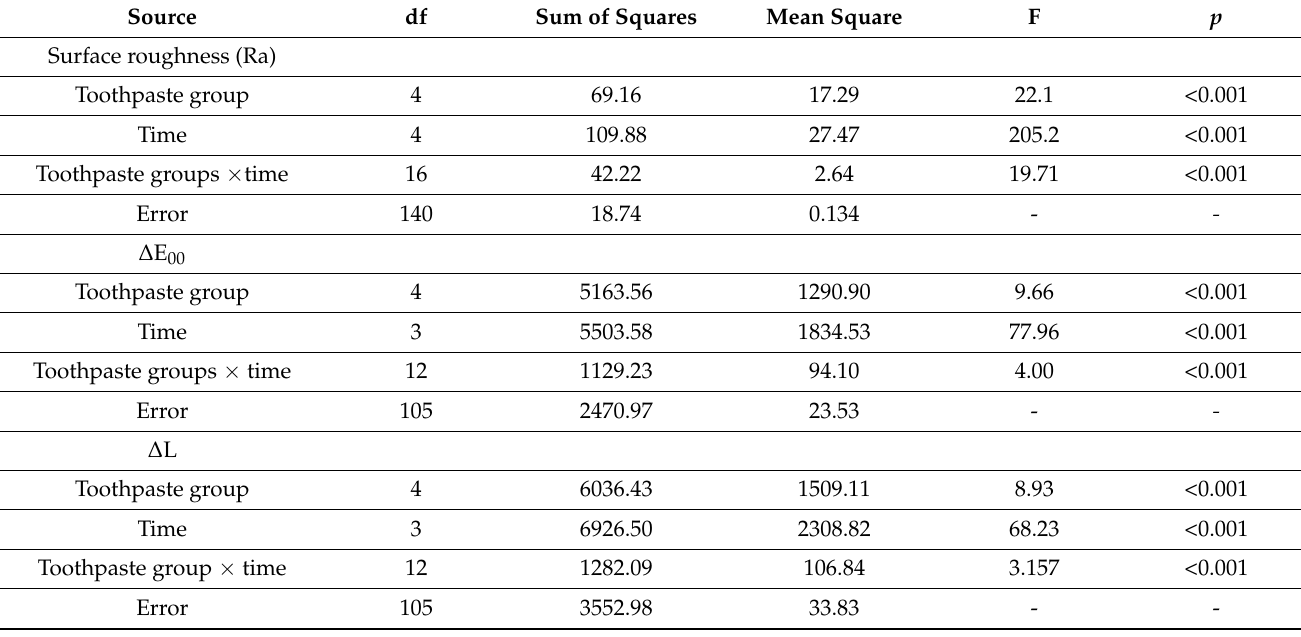
Table 2. Two-way repeated measures analysis of variance (ANOVA) of toothpaste groups and time on surface roughness, ∆ E 00 , and ∆